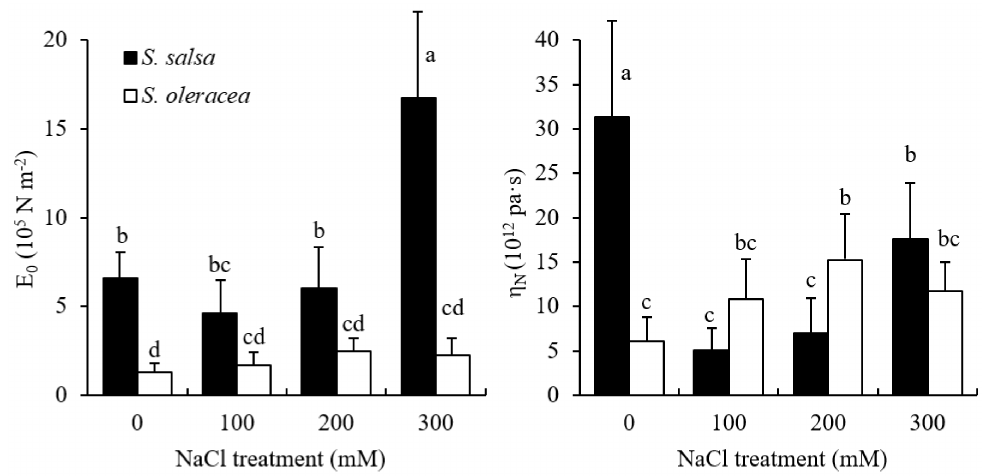
Figure 2. Elastic moduli (E 0 ) and viscosity coefficient ( η N ) of the root cell wall in the elongation zone in S. salsa and S. oleracea in 0, 100, 200, and 300 mM NaCl treatments. Data are mean + S.D. ( n = 12–15). Different letters indicate significant differences ( p <